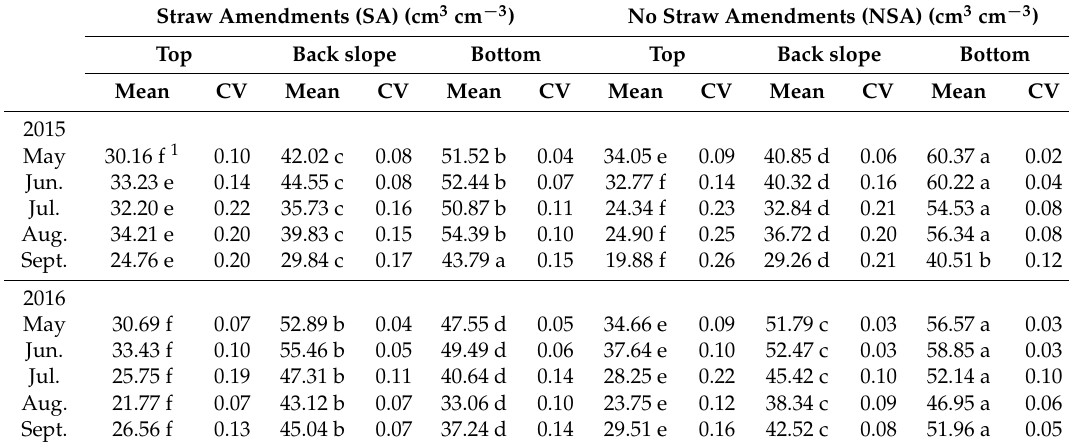
Table 4. Monthly soil moisture in the SA and NSA treatments in 2015 and 2016 ( n =